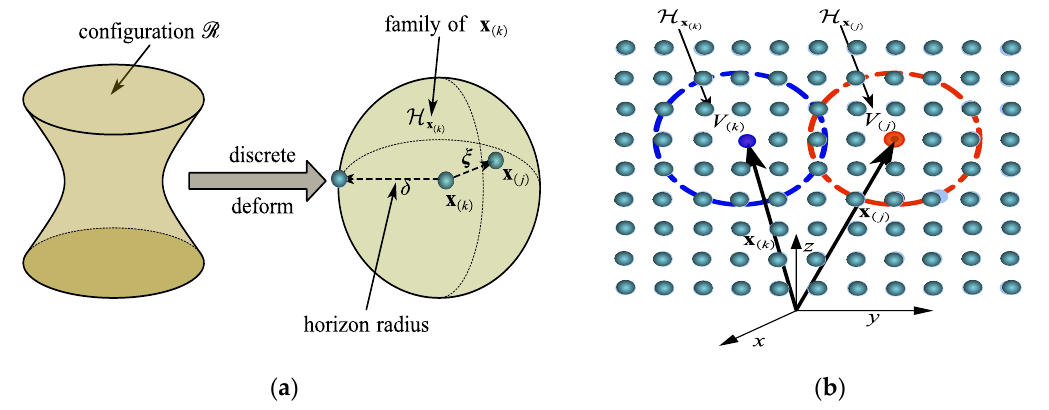
Figure 1. Kinematics of state-based PD material particles. ( a ) Peridynamic body and particle horizon; ( b ) motion of material particle within its horizon. Each point x ( k ) of the peridynamic body interacts directly with each point of the radius sphere H x , as shown in Figure 2a (the family of x ). In its deformed state Y , the deformation state eventually forms a bond ξ . The relative displacement between a material particle and the other material particles within its horizon determines the force state for that material point. Therefore, the force state can be expressed as follows: